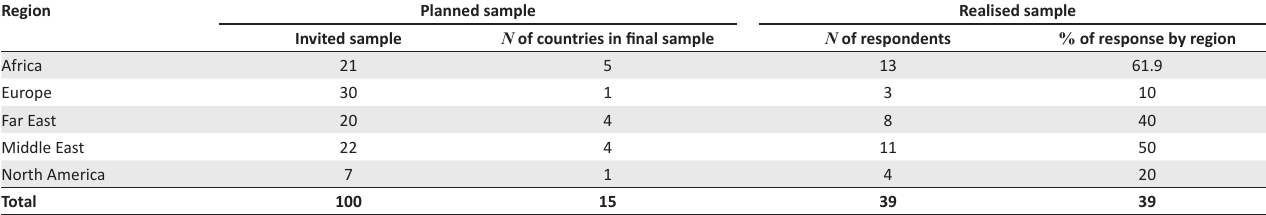
TABLE 1: Sampled countries and respondents.